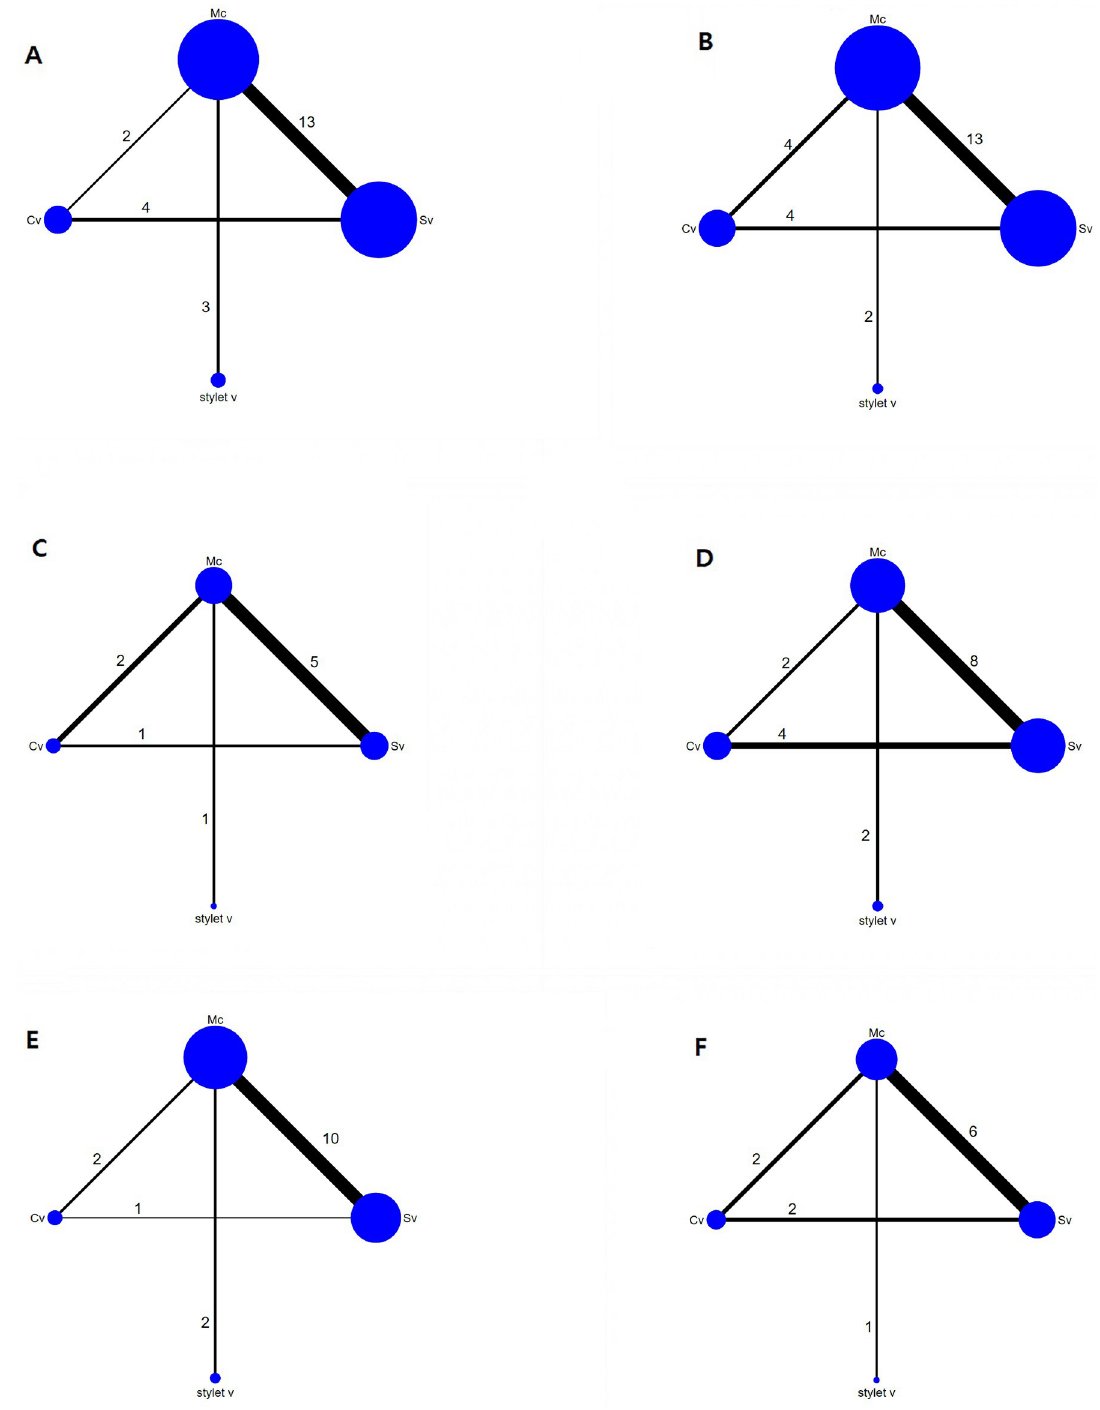
Fig 3. Evidence network plots for the outcomes showing the four types of laryngoscopes included in the network meta-analysis. The size of the nodes corresponds to the total number of studies with each device. The thickness of the lines is proportional to the number of studies making this comparison. (A) The success rate of the first attempt, (B) intubation time, (C) malposition, (D) sore throat, (E) oral mucosal damage, and (F) external manipulation. Mc, Macintosh (direct) laryngoscope; SV, standard non-channeled videolaryngoscope; CV, channeled videolaryngoscope; stylet V, videostylet.